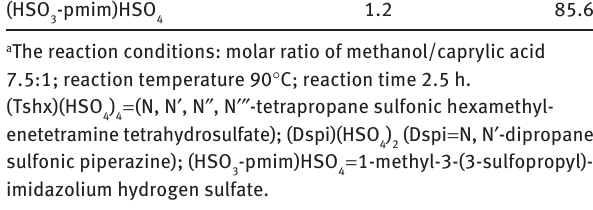
) under different amount of 4 4